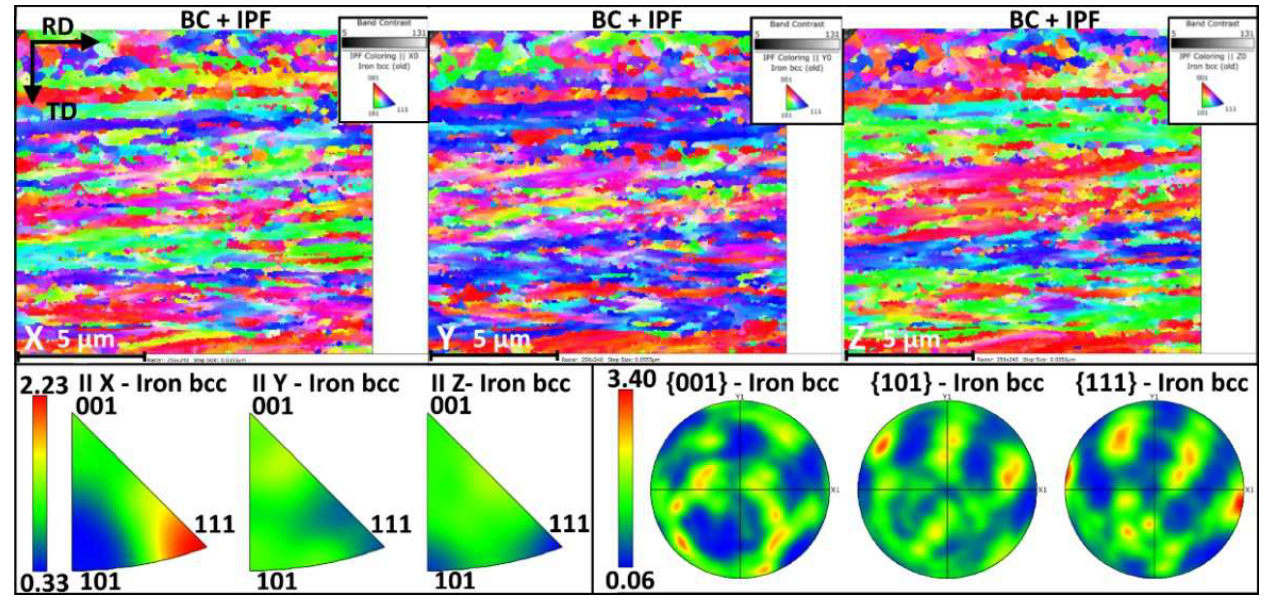
Figure 7. DP steel after 50% cold rolling observed with EBSD. Grains were observed in the x, y and z directions. The texture due to cold rolling is clearly visible. Pole figures and IPF are also shown in